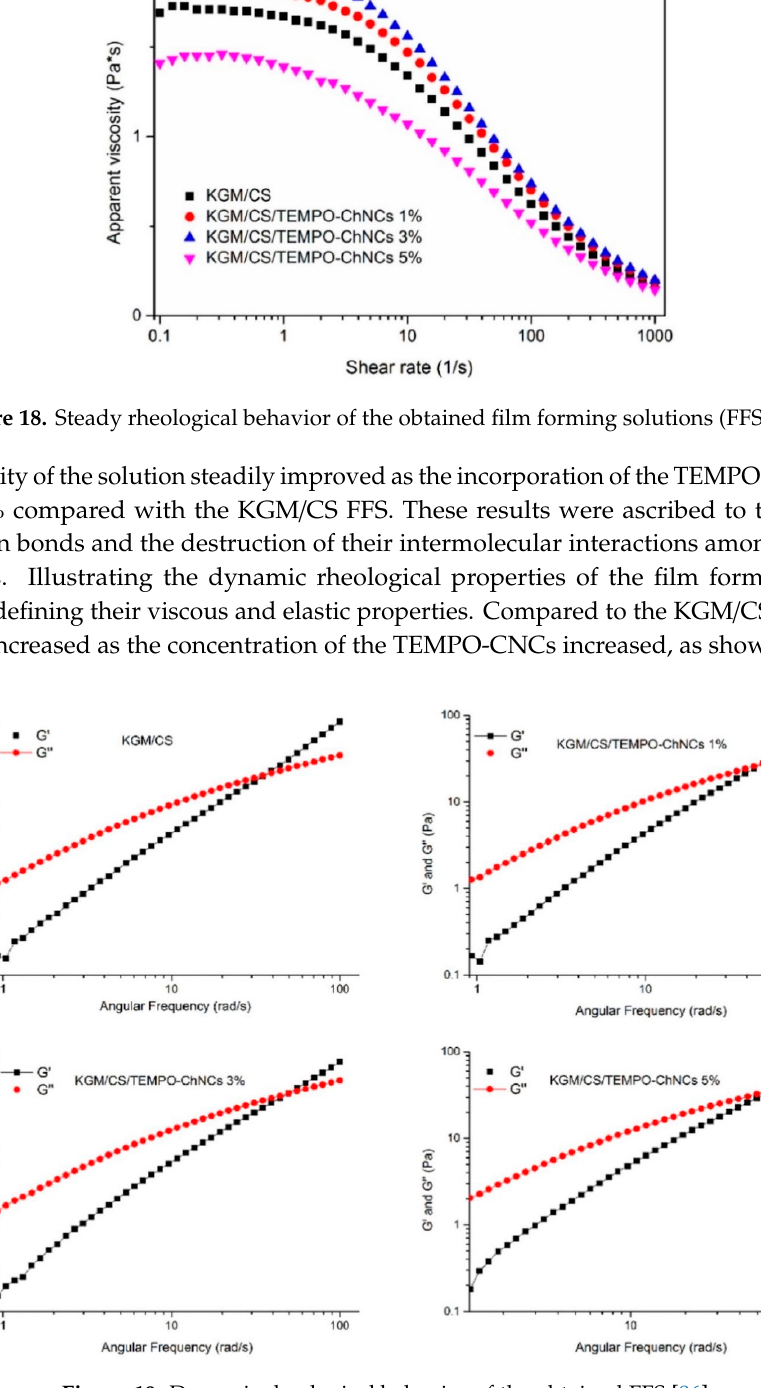
Figure 19. Dynamic rheological behavior of the obtained FFS [86].